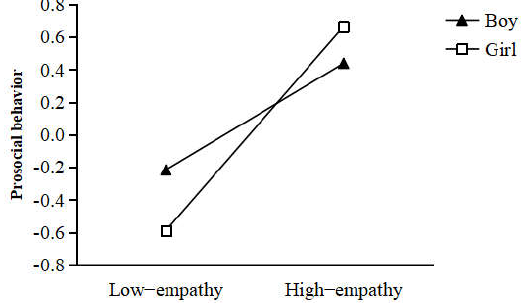
Figure 4. The moderating effect of gender on the relationship between empathy and prosocial behavior.